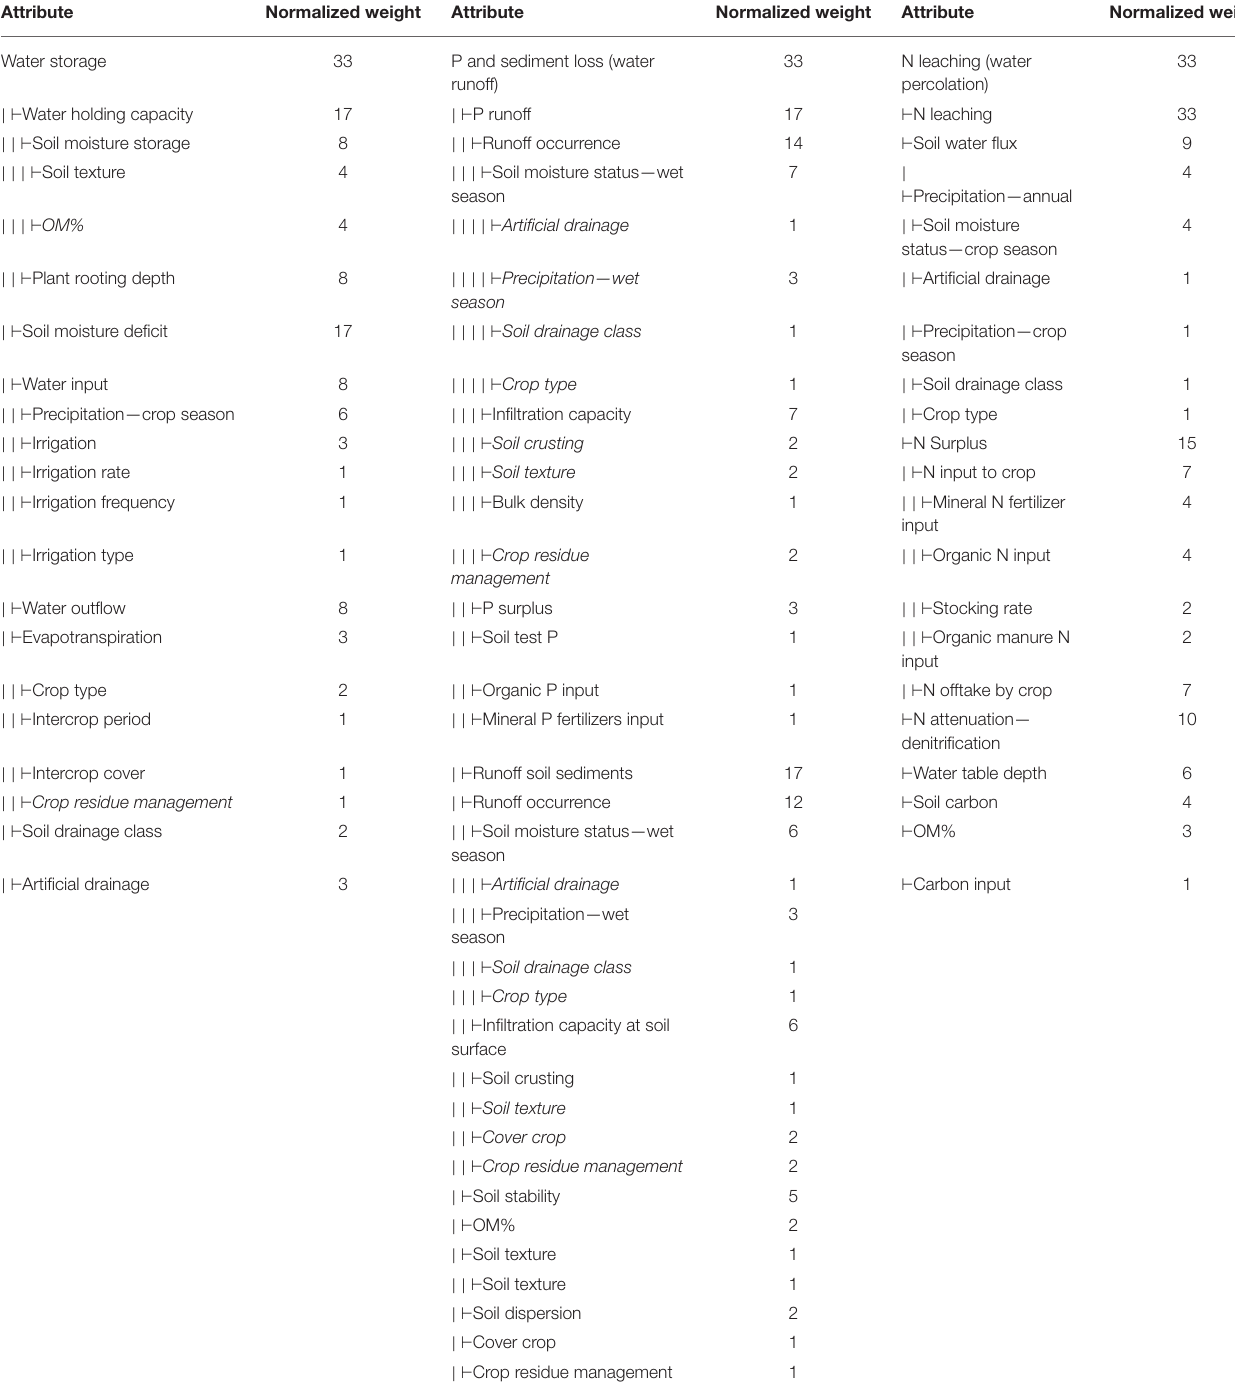
TABLE 3 | Importance of attributes and sub-models in the water regulation and purification (WR) model. Attribute Normalized weight Attribute Normalized weight